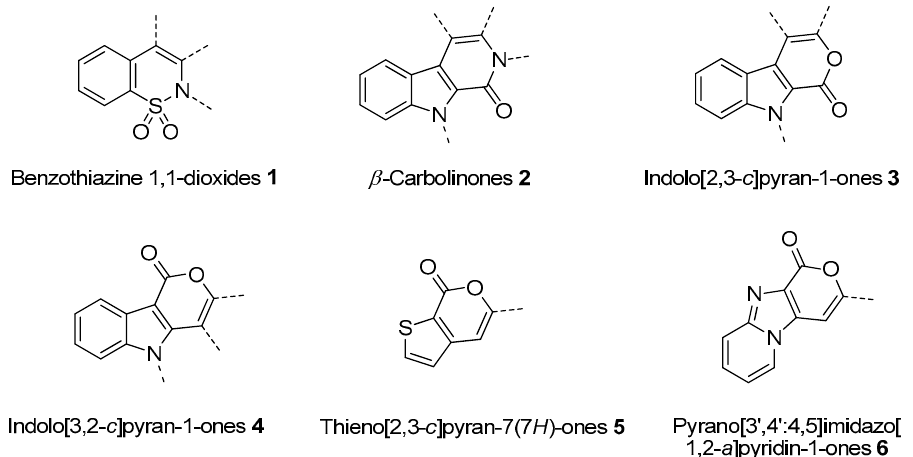
Figure 1. General structures of synthesized cores.